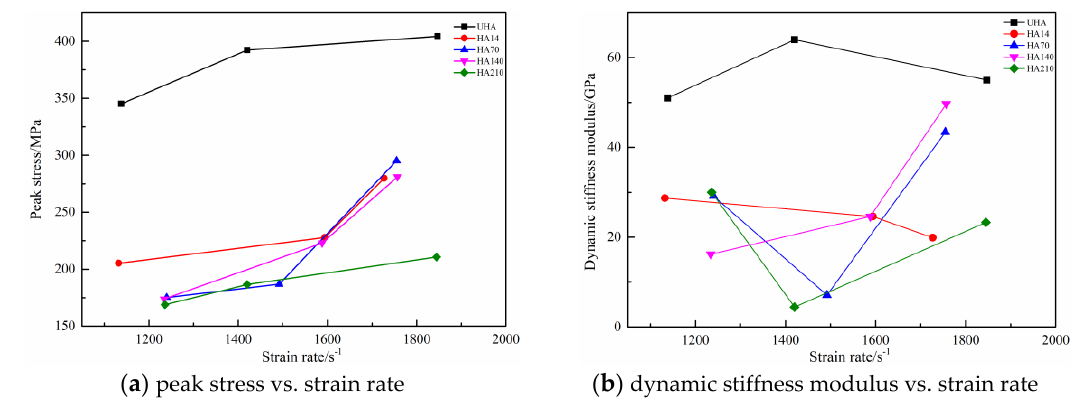
Figure 15. Dynamic mechanical property vs. strain rate for the 3D four-step braided composites under different hygrothermal aging days, ( a ) peak stress vs. strain rate, ( b ) dynamic stiffness modulus vs. strain rate.